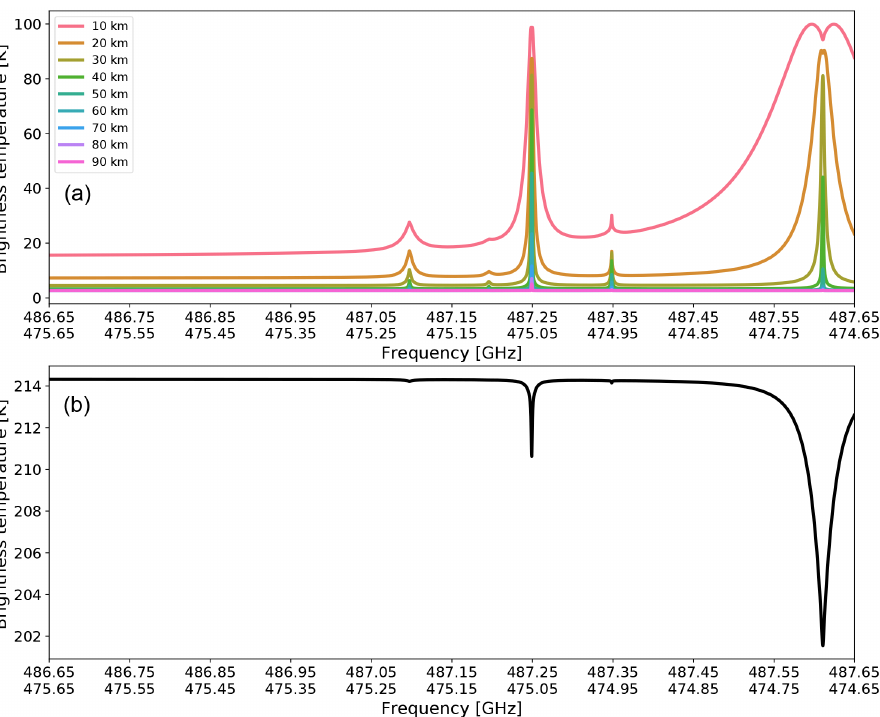
Figure 4. Simulated signal for the sensor. The signal unit is in Planck-equivalent brightness temperature as expected with the sensor calibrated to have half of its measured signal from each sideband. Panel (a) shows the simulated limb-scanning geometry for several tangent altitudes (used in later figures). The legend contains the tangent altitudes. Panel (b) shows the simulated nadir-staring mode signal (also used in later